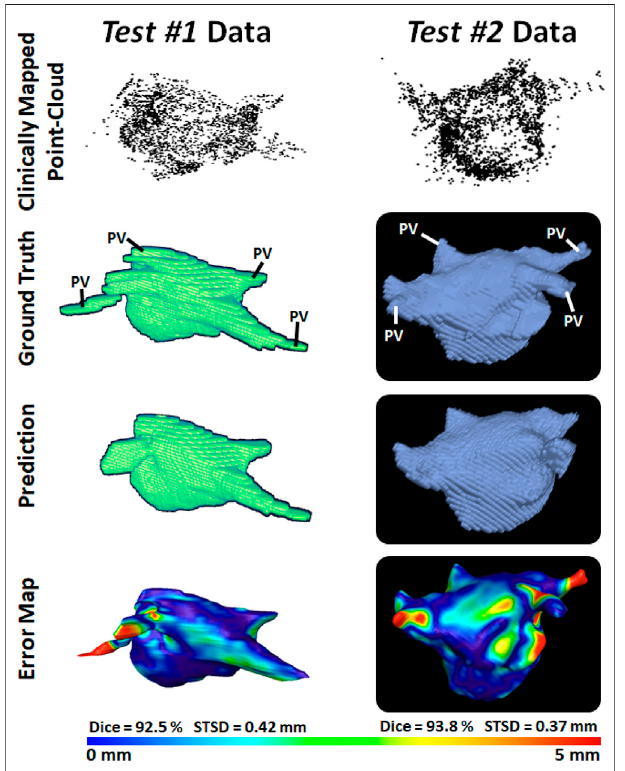
FIGURE 4 | 3D Visualizations of the left atrial (LA) reconstruction for one sample each from test #1 (left column) and test #2 (right column) clinical datasets.Thepointcloudrecordedwiththecommercialmappingsystemsare shown in the fi rst row, along with the LA geometry obtained from segmenting magnetic resonance imaging (MRI) and computed tomography (CT) in the second row. The predicted LA are shown in the third row, and the surface-to-surface distance (STSD) error maps between the ground truths and the predictions are shown in the fourth row. The individual diceand STSD scores are shown for each sample. PV, pulmonary vein.